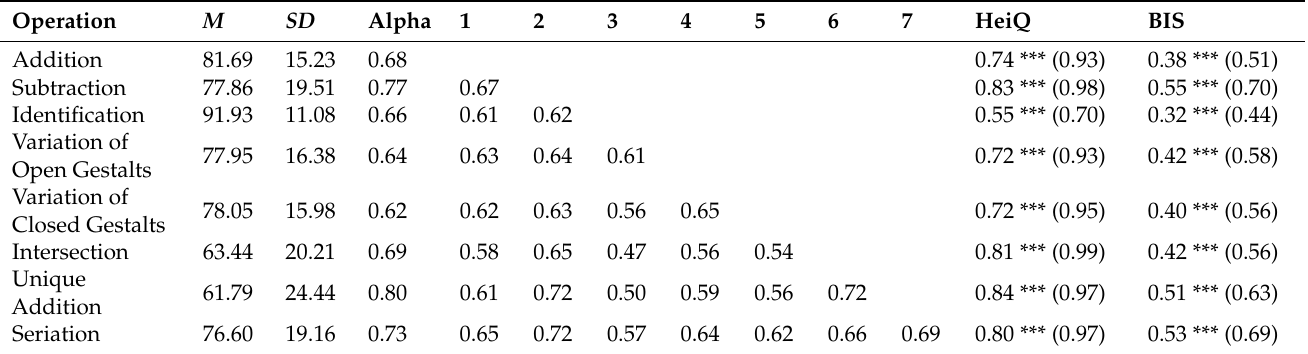
Table 7. Mean, standard deviation, Cronbach’s alpha, and correlations among operation